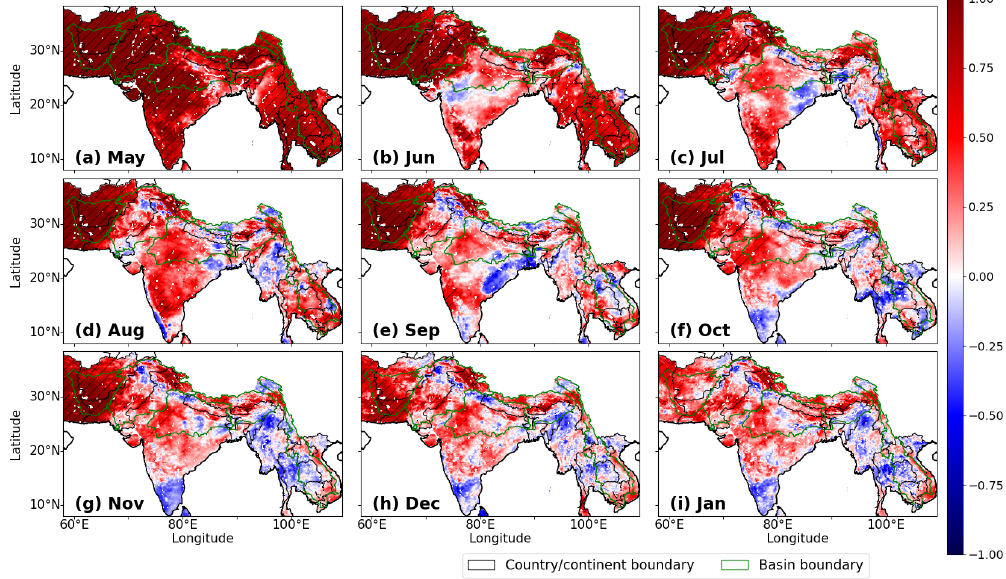
Figure 3. Inter-annual correlation of RZSM between retrospective simulations and hindcasting simulations which is computed using RZSM data from year 2000 to 2017 in months May (1-month lead time) to January (9-month lead time) (a–i) . The hatches denote the areas with statistically significant correlation at 0.95 confidence